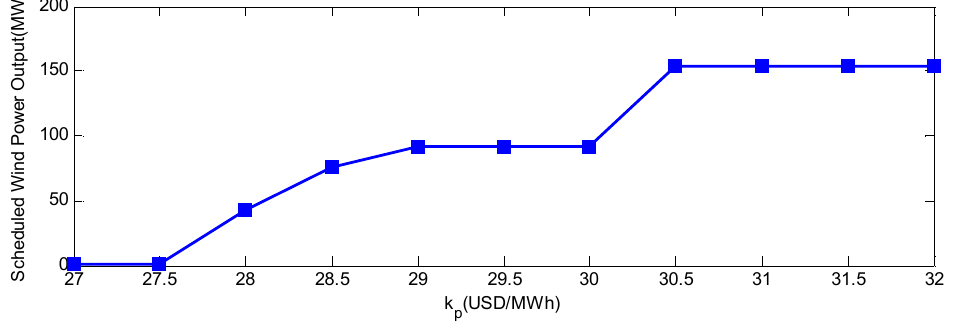
Figure 9. The scheduled wind power output as a function of down reserve cost coefficient.